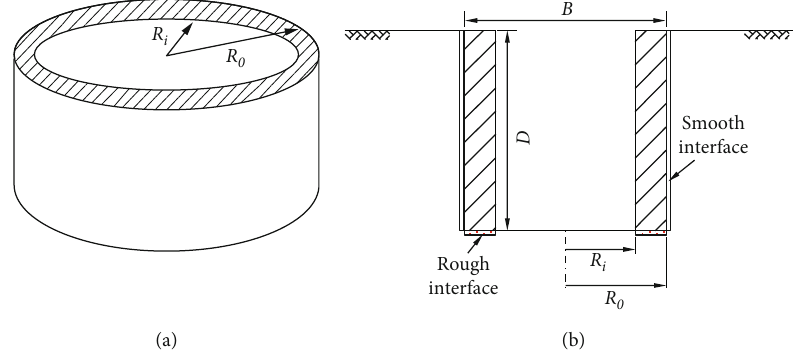
Figure 2: Schematic diagram of the ring foundation. Table 2: Numerical analysis